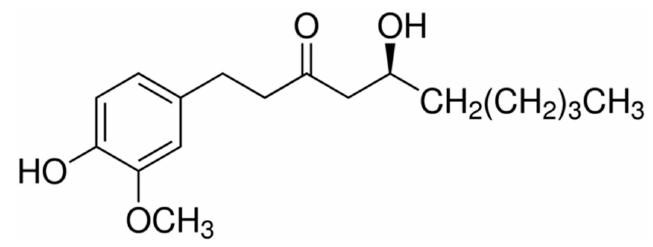
Figure 1. Chemical formula of 6-gingerol.